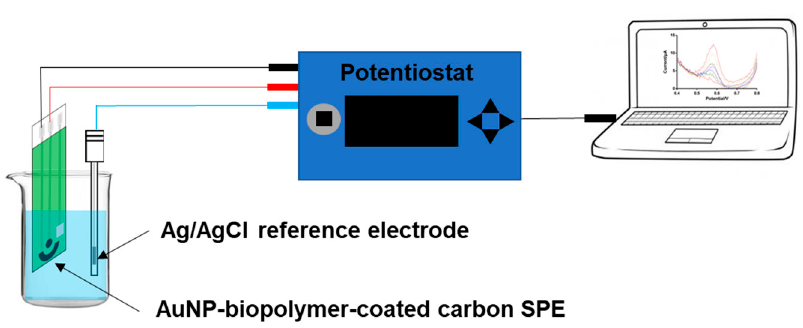
Figure 1. Measurement setup schematic for testing an AuNP-biopolymer-coated carbon SPE.